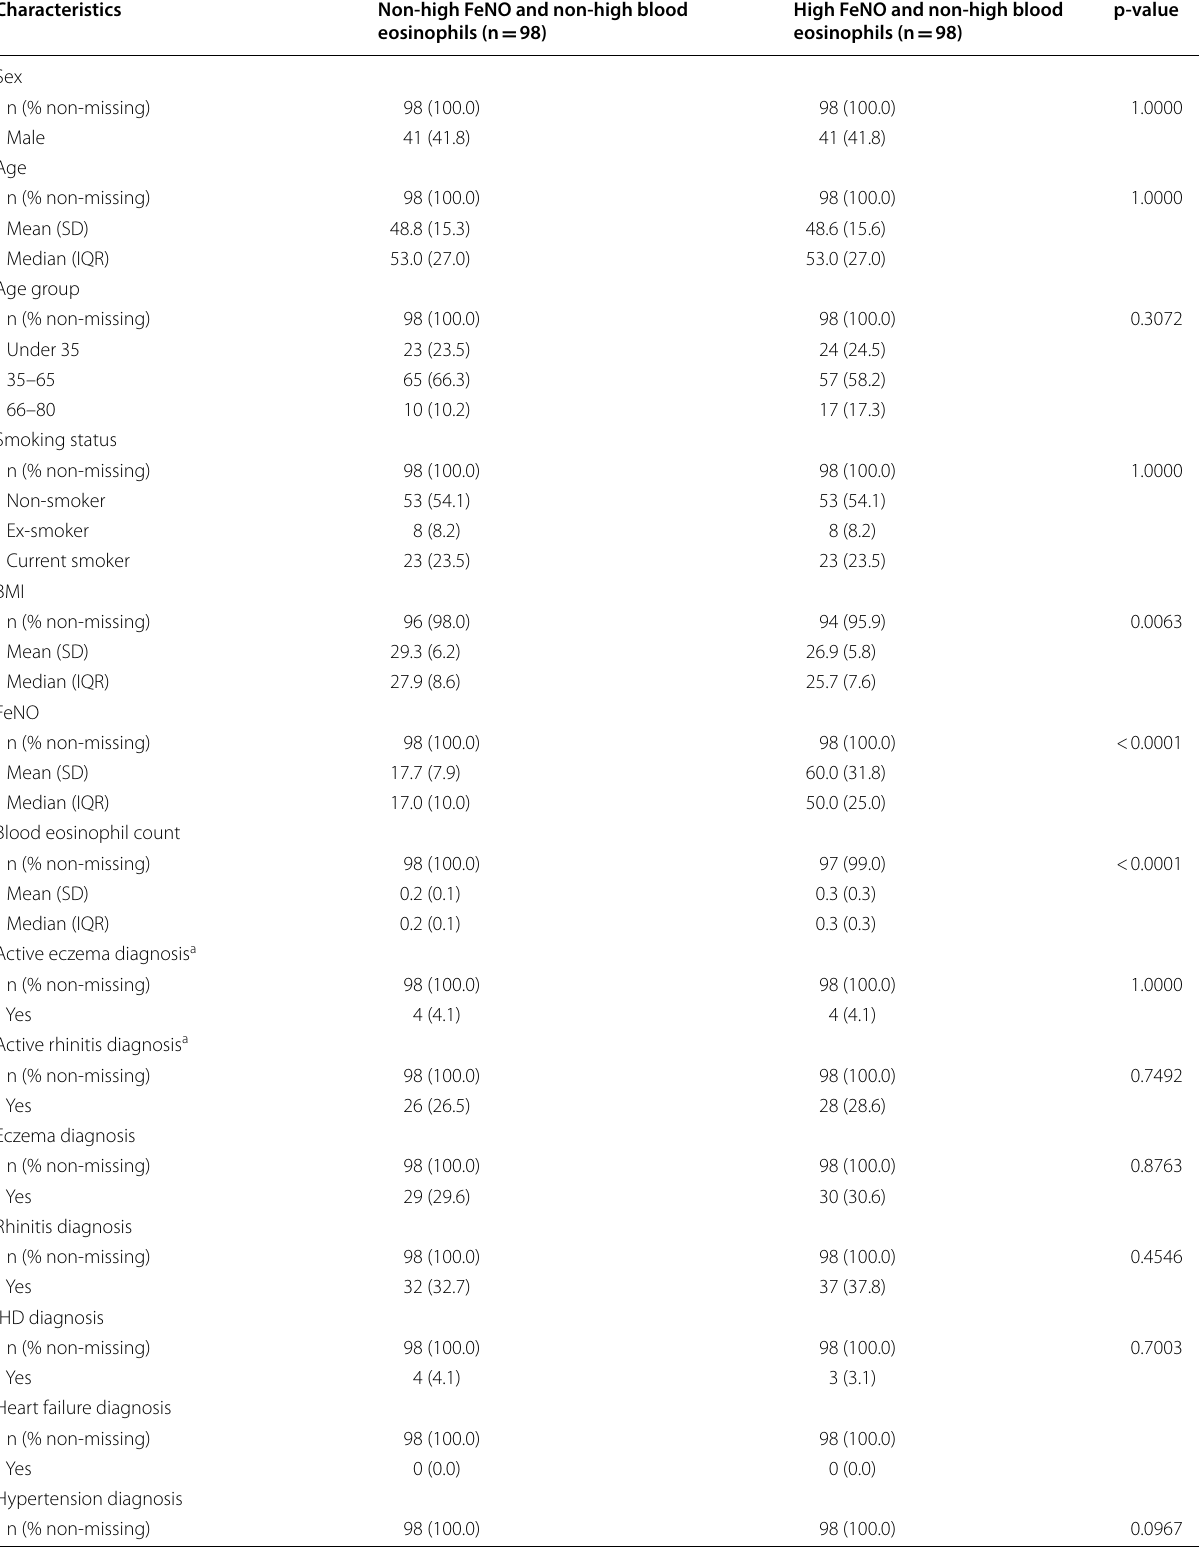
Table 4 Categorisation 2: non-high FeNO and non-high blood eosinophils vs. high FeNO and non-high blood eosinophils